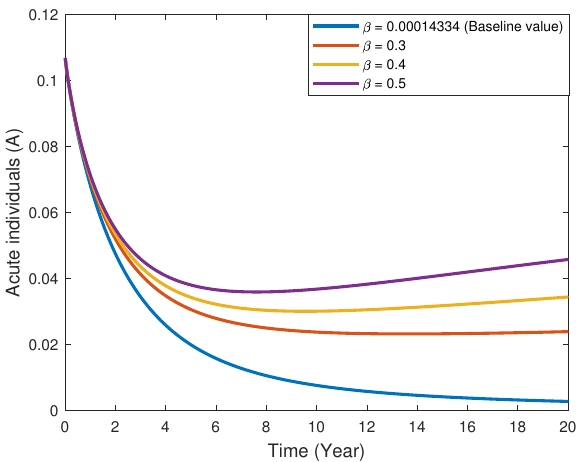
Figure 11. Behavior of A class for different β values.